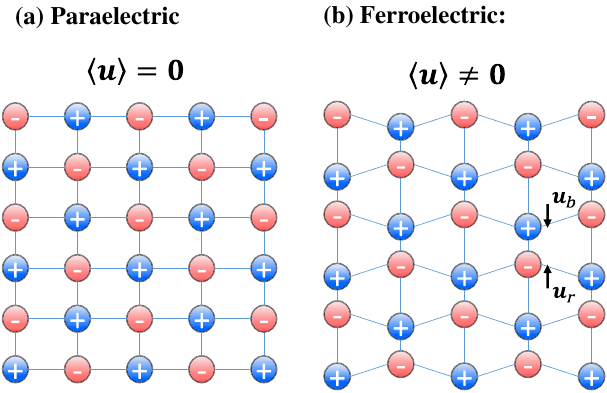
FIG. 1. (a) A diatomic cubic ionic crystal in the paraelectric phase. The two ions are represented by blue ( þ ) and red ( − ) circles (e.g., blue for Pb and red for Te). Unless these two atoms are identical, they will have an average charge imbalance. (b) The ferroelectric phase (inversion breaking) is characterized by a uniform optical phonon displacement vector u ¼ u b − u r . Be- cause of the charge imbalance between the ions, this phase is also characterized by a finite dipolar polarization density P ¼ Q u , where Q is the